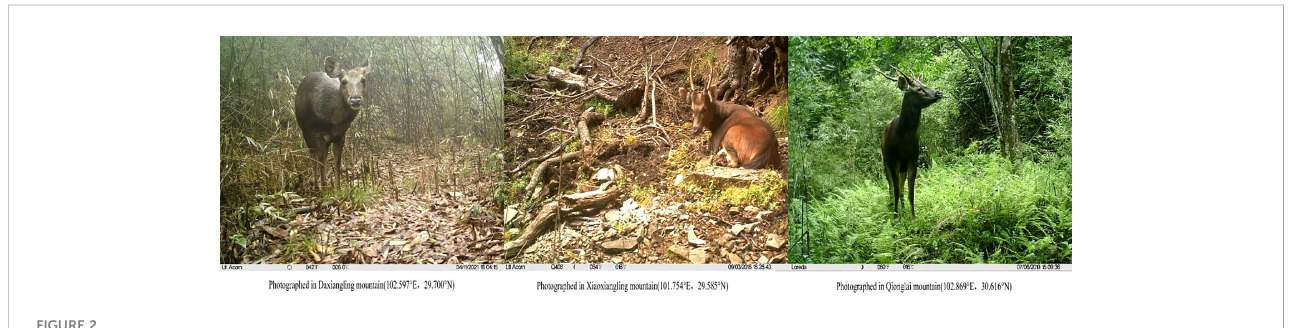
FIGURE 2 Photos of sambar from camera